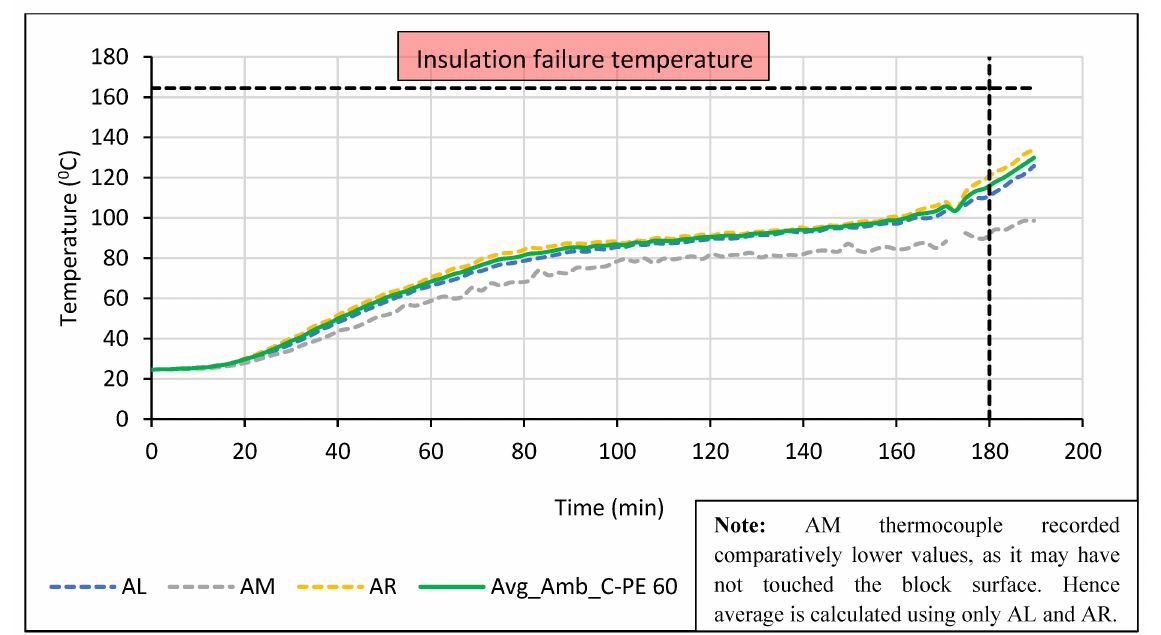
Figure 32. Ambient side surface time–temperature curves of C-PE 60 block from the building fire test.